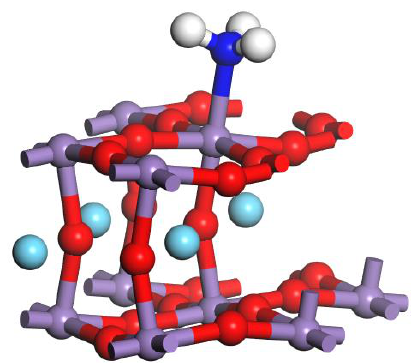
Figure 2. The adsorption configuration of NH 3 . Table 1. The parameters of optimized NH 3 adsorption configuration.